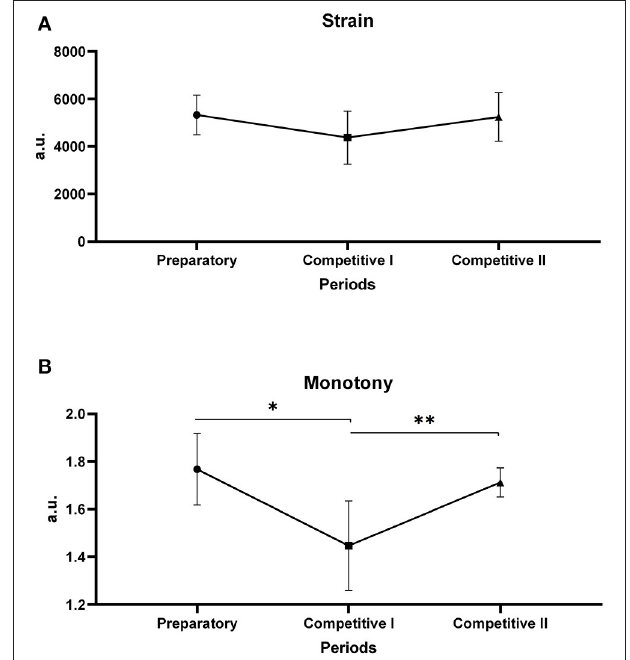
FIGURE 3 | (A) The strain between periods. (B) Monotony between periods. *Difference between preparatory period and competitive period I, **Difference between competitive period and competitive period